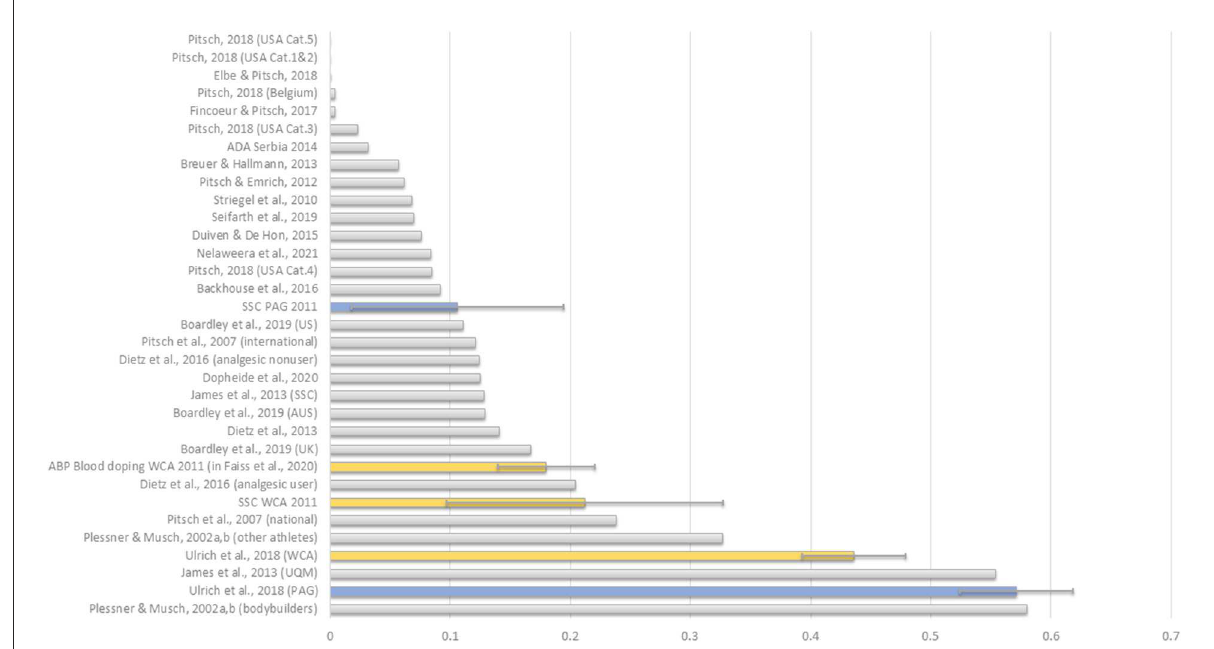
FIGURE3 Comparison of doping prevalence estimates for WCA and PAG between the two survey formats, and with literature evidence. Data extracted from Table 1 using the most relevant figure (i.e., elite level and current/last season/past 12 months) when multiple estimates are reported.